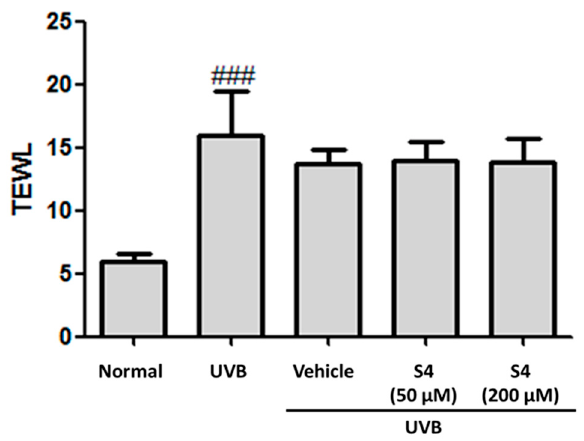
Figure 10. Effect of S4 on transepidermal water loss (TEWL) in chronic UVB-irradiation hairless mice at the 10th week. Significant difference versus normal group: ###, p < 0.001.